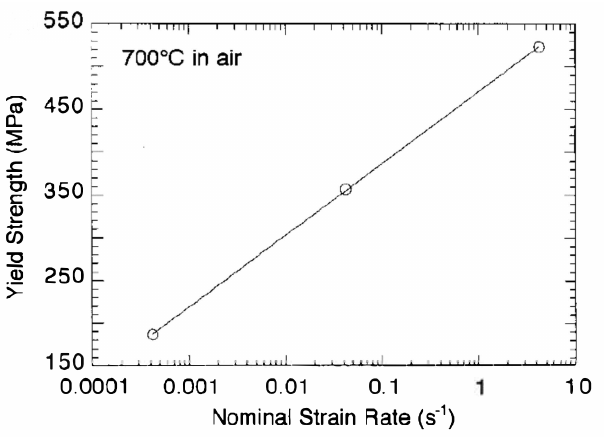
Figure 23. Variation in yield strength with strain rates for Fe-40Al-0.6C alloy. Reprinted with permission from ref. [12]. Copyright 1998